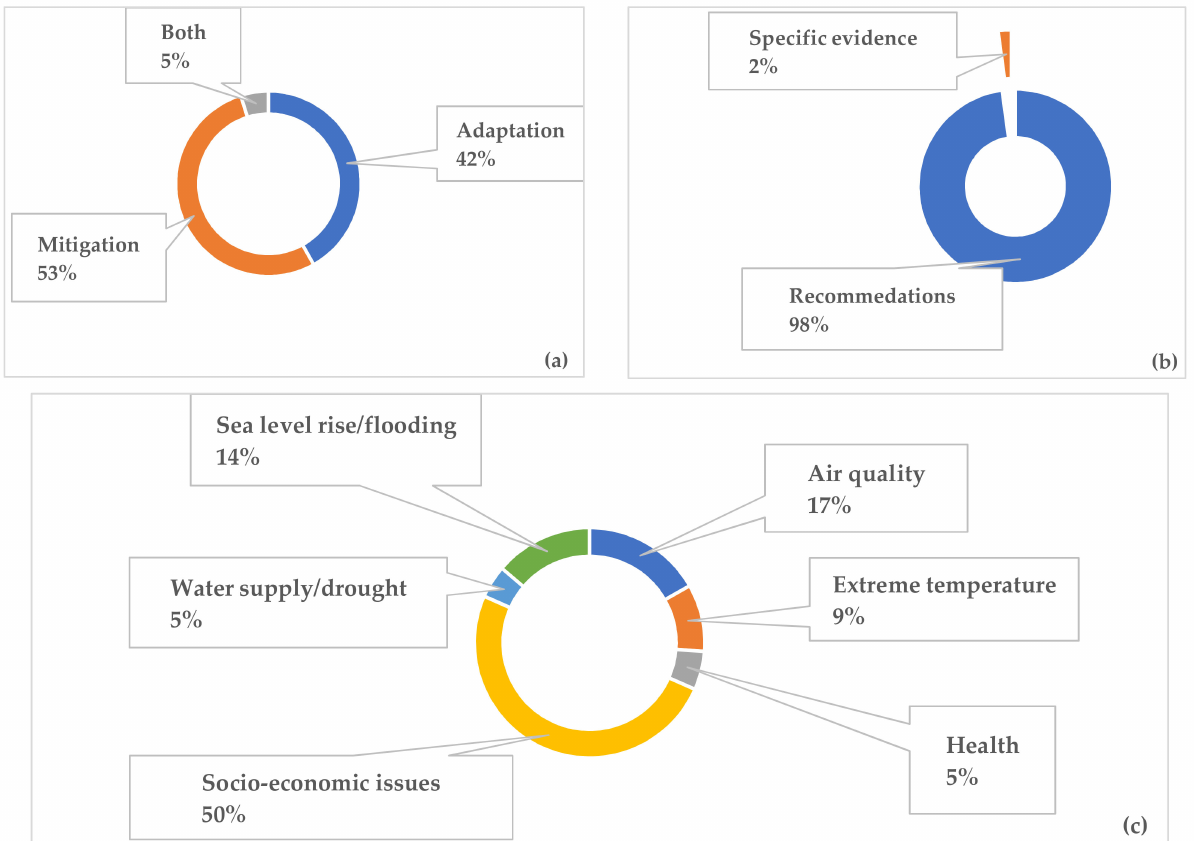
Figure 5. Study focus ( a ), outcome ( b ), and main concerns ( c ) raised in the literature used in the